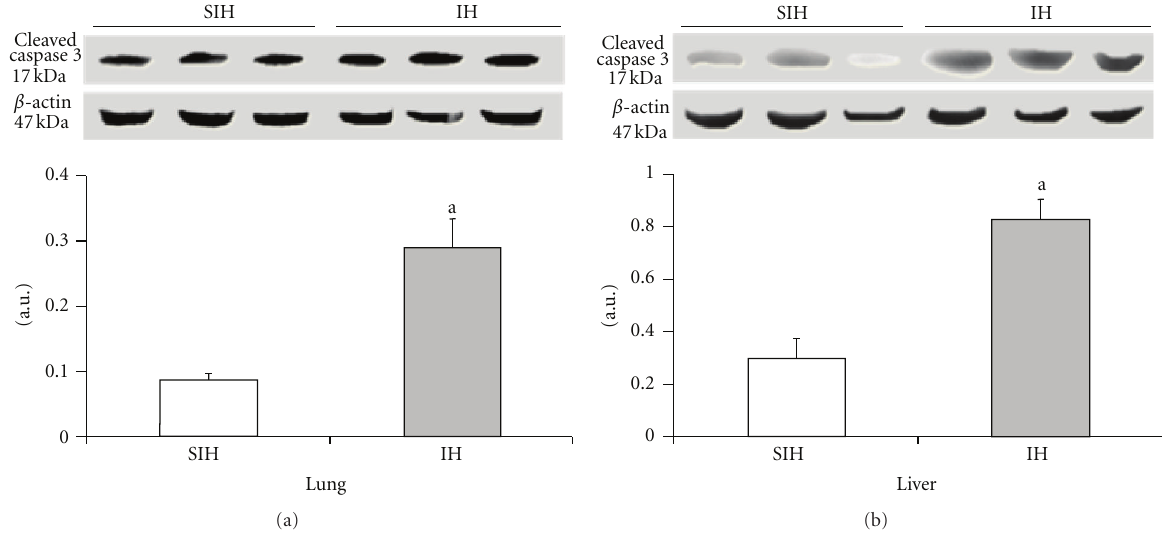
Figure 6: The e ff ect of intermittent hypoxia on the expression of cleaved caspase 3 in the liver ((a), P = 0 . 0022) and lung ((b), P = 0 . 0003). Results are reported as mean ± standard error, n = 6 per group. P value according to Student’s t